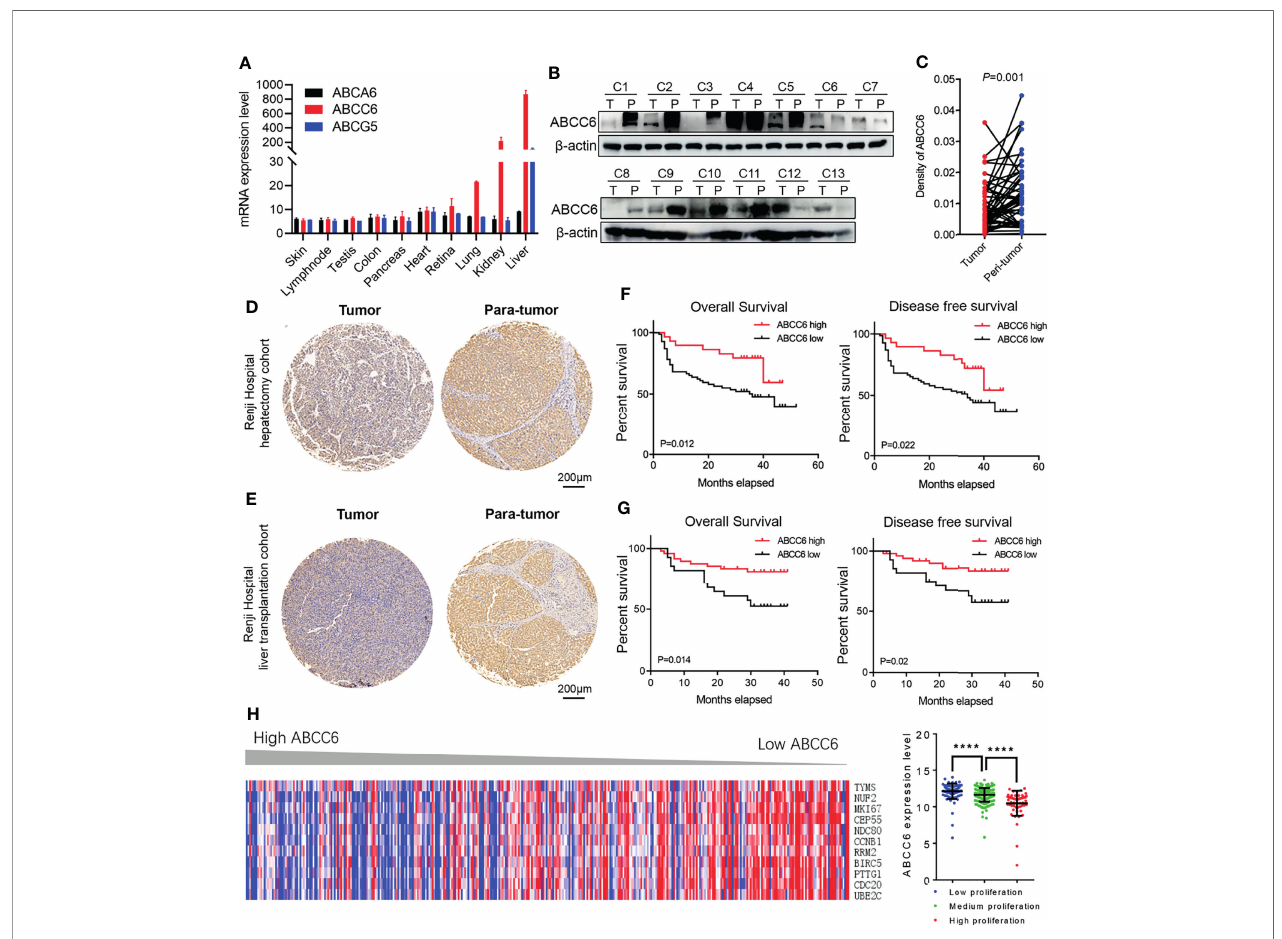
FIGURE 3 | The clinical outcomes of ABCC6 in patients with HCC. (A) BioGPS database showing the mRNA expression level of ABCA6 , ABCC6 , and ABCG5 in different normal human tissues. (B) Western blotting displaying ABCC6 protein levels in 13 pairs of HCC tumor and paratumor tissues. (C) Statistical analysis showing the differential protein level of ABCC6 in Renji Hospital hepatectomy HCC tissue array. (D) Representative IHC fi gure showing the ABCC6 protein level in Renji Hospital hepatectomy HCC tissue array. (E) Representative IHC fi gure showing the ABCC6 protein level in Renji Hospital liver transplantation HCC tissue array. (F) Kaplan-Meier analysis showing the overall survival and disease-free survival of HCC patients in correlation with high or low ABCC6 levels in Renji Hospital hepatectomy cohort. (G) Kaplan-Meier analysis showing the overall survival and disease-free survival of HCC patients in correlation with high or low ABCC6 levels in Renji Hospital liver transplantation cohort. (H) Heatmap and histogram showing the expression of proliferation-related genes in correlation with different ABCC6 expression level. Data was derived from TCGA dataset. Error bars indicate means ± SEM. P -values were determined by two tailed t -test (C) , one-way ANOVA (H) and Kaplan-Meier analysis (F, G) . **** P < 0.0001.